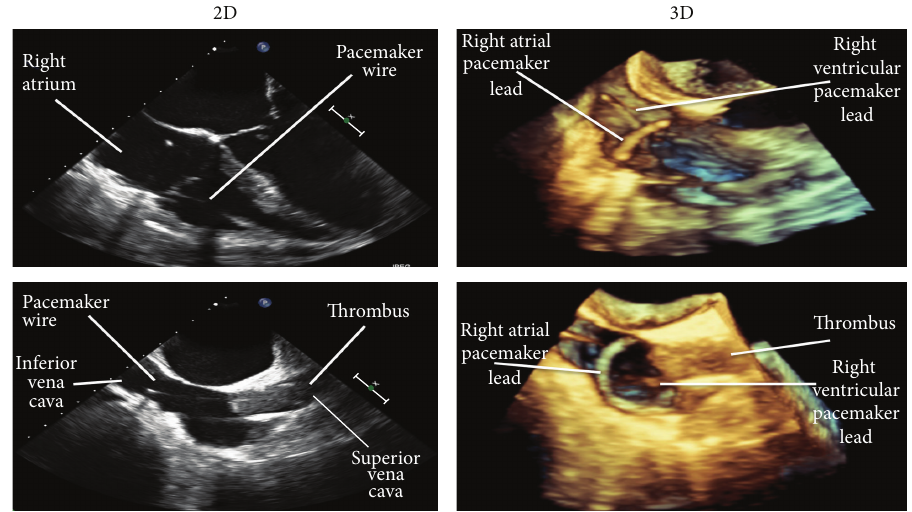
Figure 2: 3D echocardiogram demonstrated the tract of the pacemaker wires clearly and showed that the venous thrombosis was separate from the pacemaker wires. In comparison, 2D echocardiography is less